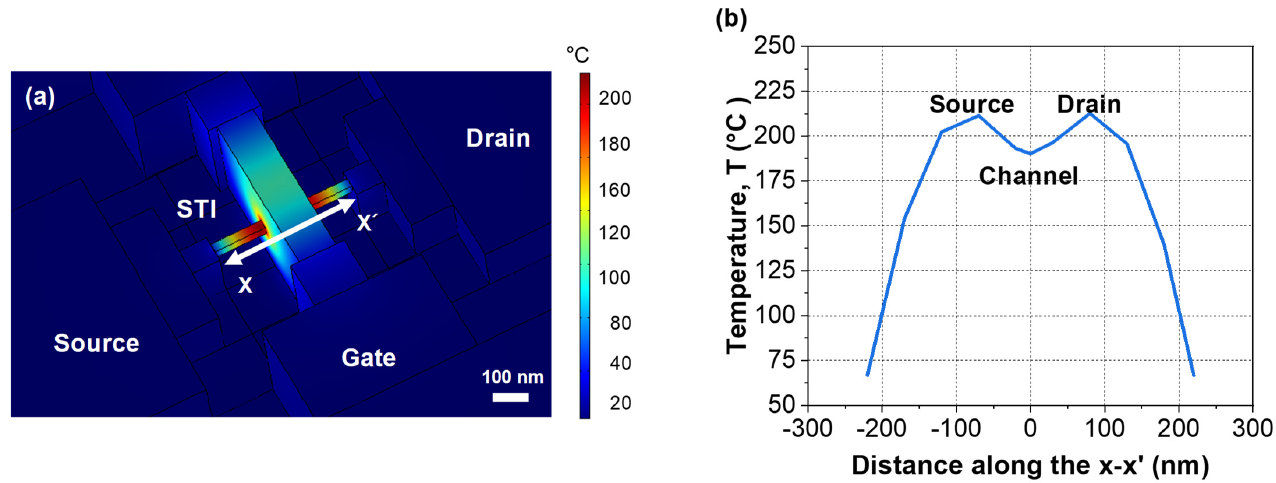
Figure 4. ( a ) Simulated heat distribution division profile during punch-through-based ETA under bias conditions with V G = 0.5 V, V S . = 0 V, and V D = 6 V. ( b ) Extracted temperature of the device along the x–x´ direction during ETA.